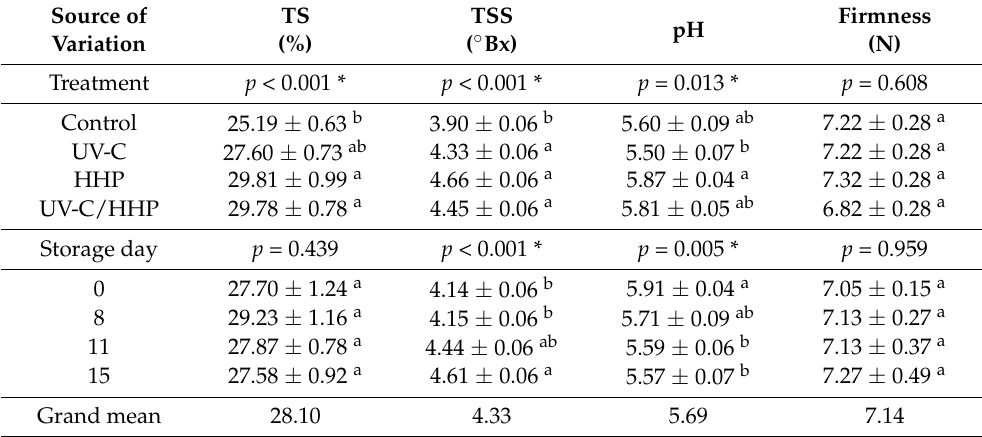
Table 1. The influence of UV-C, HHP, and UV-C/HHP treatment and storage time on total solids content (TS), total soluble solids content (TSS), pH, and firmness of raw, fresh-cut